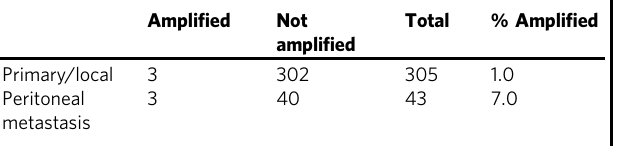
Table 1 ERBB2 ampli fi cation status in primary and metastatic samples of a CCC patient